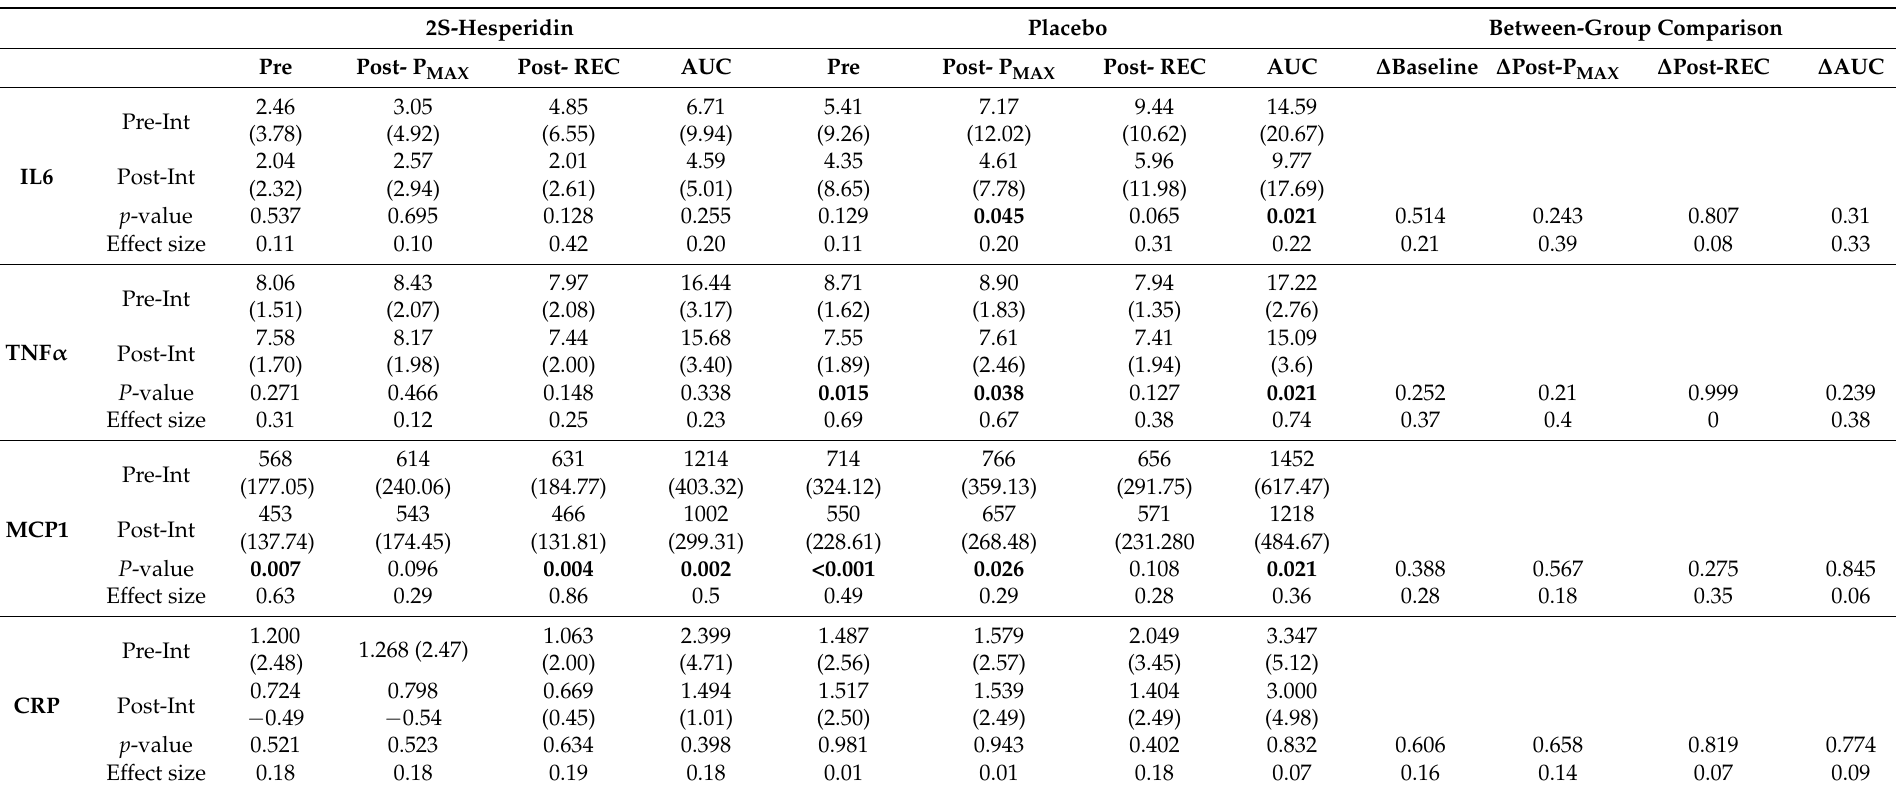
Table 4. Changes in inflammatory status markers before, during and after rectangular test comparing pre- and post-intervention.